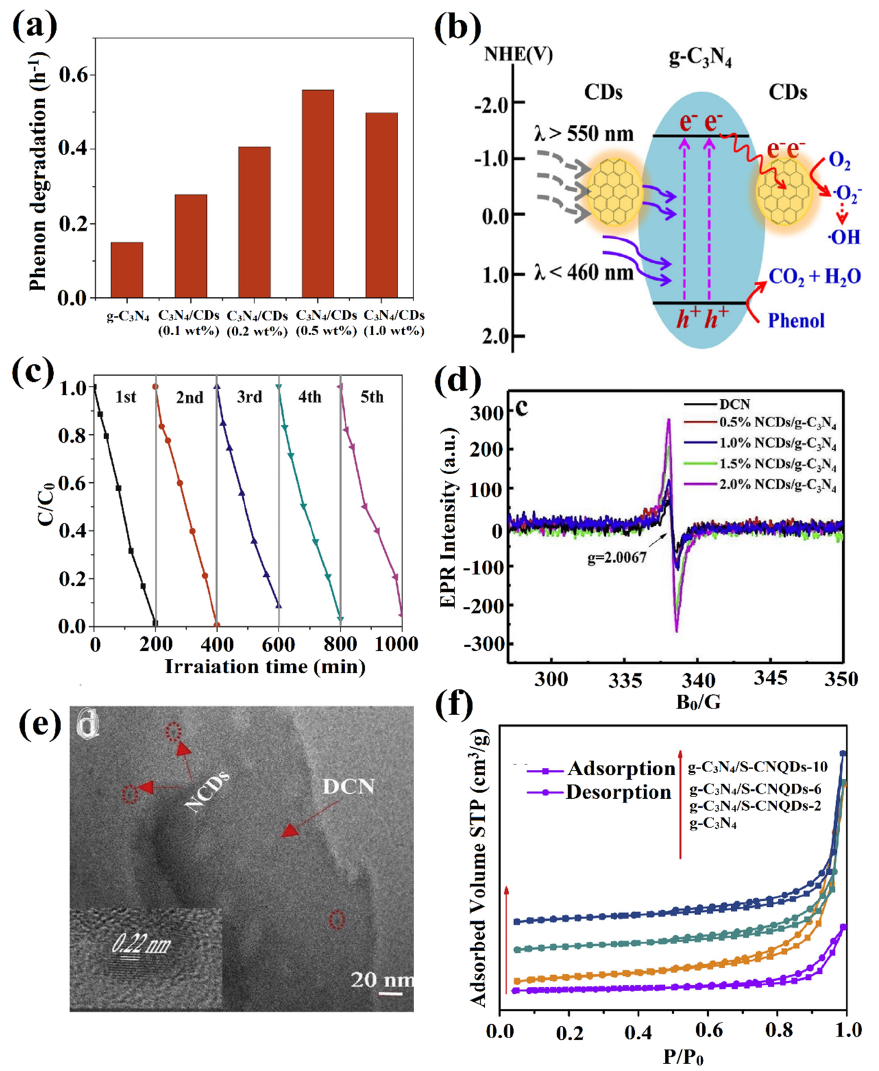
Figure 4. ( a ) The rate constant of phenol degradation by different nanocomposite, ( b ) pictorial representation of the possible photocatalytic mechanism of the g ‐ C 3 N 4 /CQDs nanocomposite under visible ‐ light irradiation, ( c ) recyclability test of g ‐ C 3 N 4 /CQDs nanocomposite, ( d ) room temperature electron paramagnetic spectrum, ( e ) 1 wt% N ‐ doped CQDs/defect ‐ rich g ‐ C 3 N 4 , (inset: lattice spacing of 1 wt% N doped CQDs/defect ‐ rich g ‐ C 3 N 4 ), and ( f ) N 2 adsorption–desorption isotherm at 77 k of S ‐ doped CQDs/g ‐ C 3 N 4 hybrid composite. Reproduced with permission from Refs. [61,63,64] with license number 5043040500456, 5043050600748, 5043050849974, Copyright Elsevier 2016, 2020.